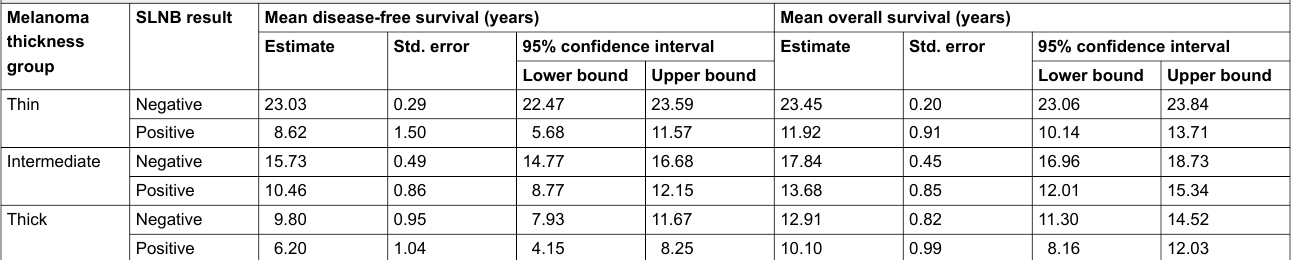
Table 4: The association between sentinel lymph node biopsy (SLNB) result and clinical outcomes in patients with different melanoma thicknesses. Mean disease-free survival